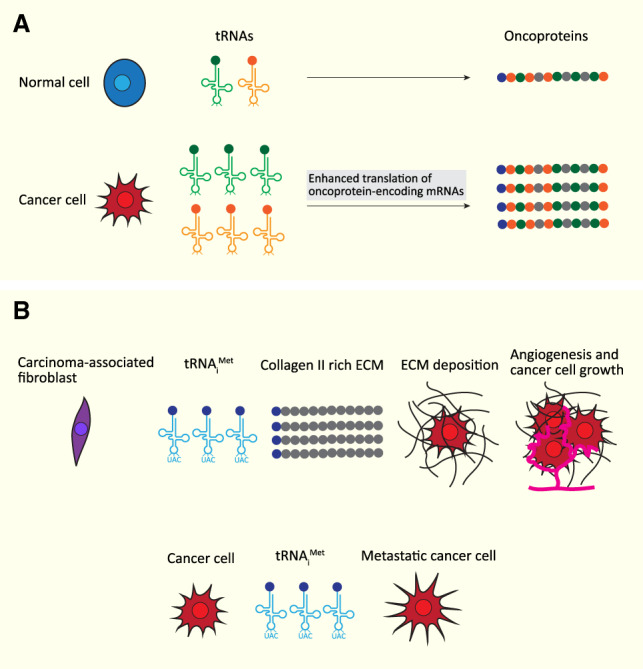
tRNA overexpression in cancer. (A) Overexpression of tRNA isoacceptors whose corresponding codons are enriched in oncoprotein-encoding mRNAs are observed in breast cancer (Pavon-Eternod et al. 2009; Goodarzi et al. 2016). (B, top panel) Overexpression of tRNAiMet in carcinoma-associated fibroblasts enhances translation of secreted collagen II-enriched ECM components, leading to angiogenesis and cancer cell growth (melanoma and lung carcinoma) (Clarke et al. 2016). (Bottom panel) Overexpression of tRNAiMet by the melanoma cells leads to increased migration and invasion, which is dependent on α5β1 integrin (Birch et al. 2016).